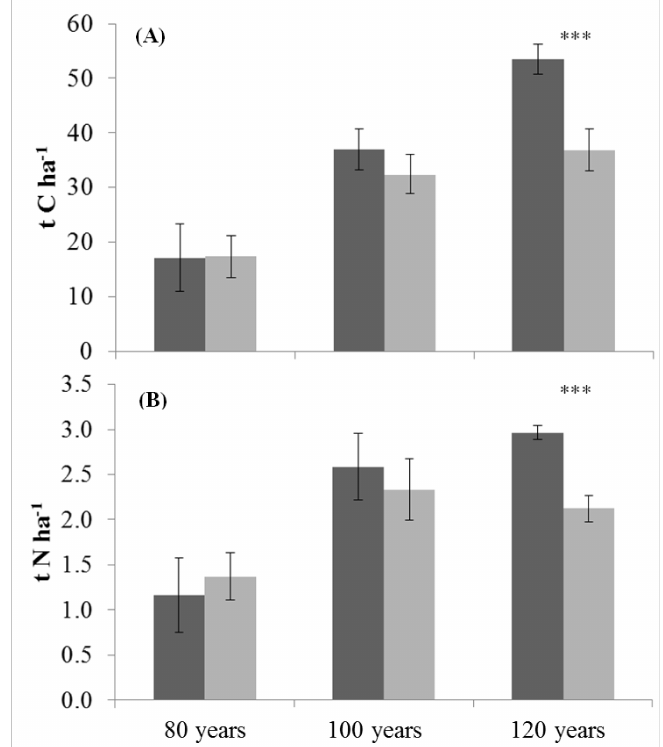
Figure 4. Soil carbon ( A ) and nitrogen ( B ) stocks in epipedon (dark grey) and endopedon (light grey) along the Douglas fir stand chronosequence. Bars are standard errors, asterisk indicate significant difference (*** p < 0.001) between epipedon and endopedon at each stand age ( n =